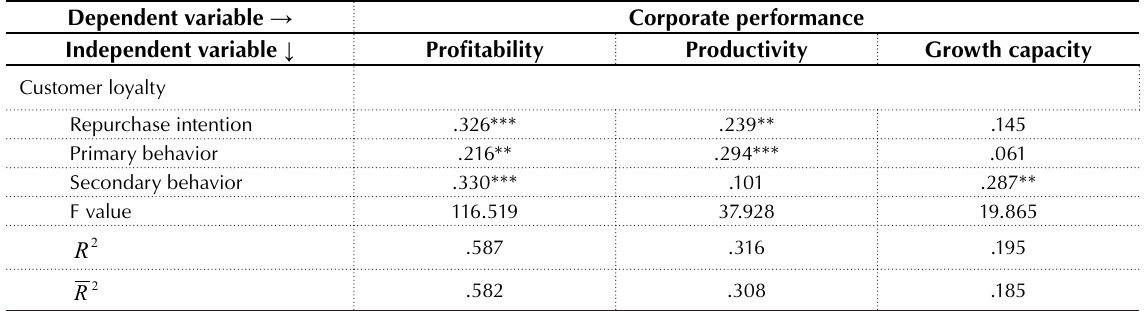
Data source: self-organized in this study.